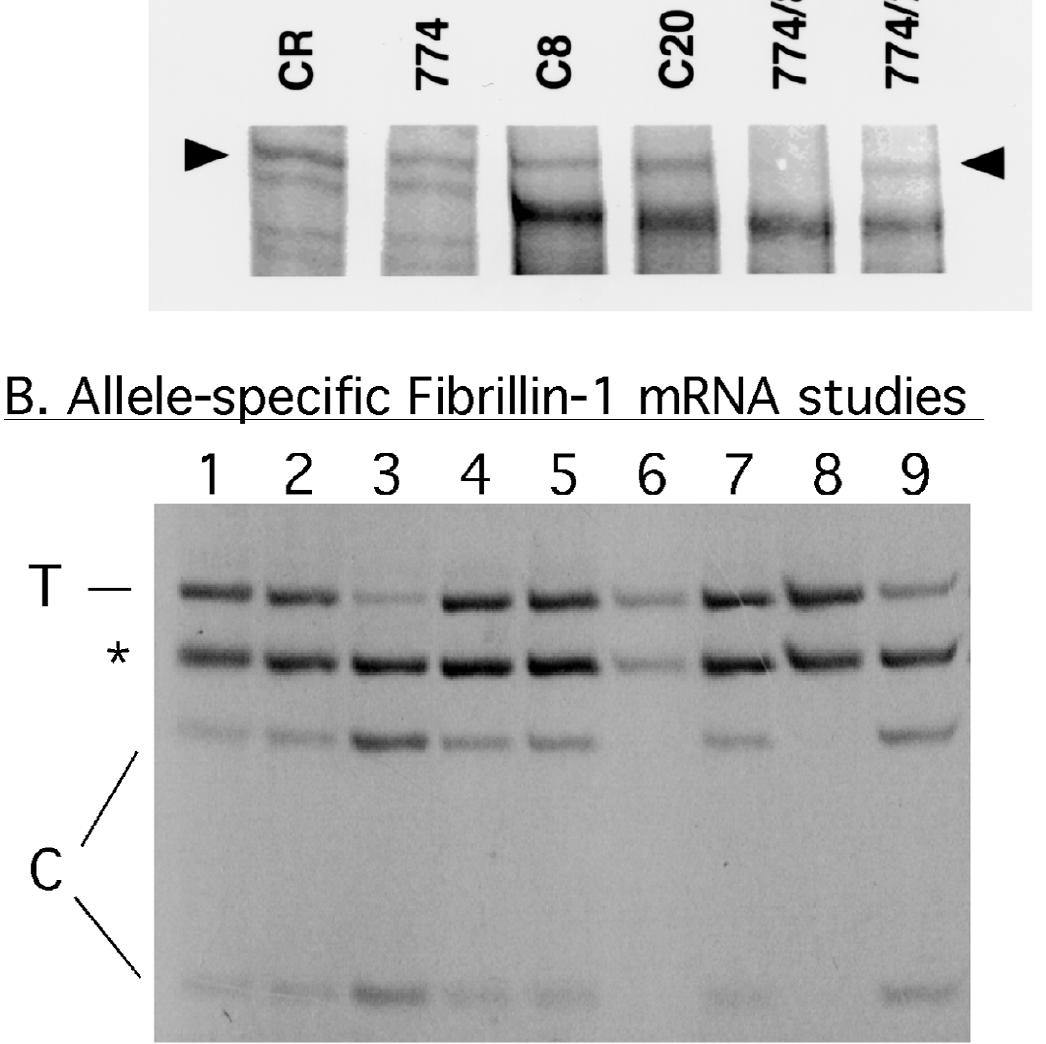
Figure 3 A. As a measure for fibrillin synthesis, the two left lanes show labeled fibrillin (arrow head) detected in the cytosol of fibrob- lasts from a normal control (CR) and from Case 1 (774) after a 30 min pulse with 35 S-cysteine. The amount in lane 774 is 55% of that in lane CR. In the right four lanes, the incorporation of pulse-labeled fibrillin (arrow head) into the extracellular matrix, after 8 hour and 20 hour chase periods, is severely reduced in Case 1 (774/8 and 774/20) compared to the normal control fibroblasts (C8 and C20). B. Allele-specific RNA analysis. All individuals are heterozygous for the C6236T Rsa I polymorphism in the FBN1 3'UTR. RT-PCR products from fibroblast RNA samples were digested with Rsa I and electrophoresed on an SSCA gel under denaturing conditions. The band labeled T represent the uncut T allele, the two bands labeled C represent the cut C allele, and the band marked by asterisk is constant. Samples 1 and 5 are normal controls, sample 2 has an exon 51 skipping mutation [19], and the sample in lane 4 is from Case 1 (774) with deletion of exons 42 and 43. Both these samples, as well as the one in lane 7 show the normal pattern of fragments indicating equal transcripts of both alleles. In contrast, sample 3 reveals predominant transcripts with the C allele, while in samples 6 and 8 only the T allele is detectable. Lane 9 shows slight skewing towards the C allele. Samples 3 and 8 have FBN1 mutations leading to premature stop codons. For samples 6,7 and 9, no FBN1 mutations have been identified as